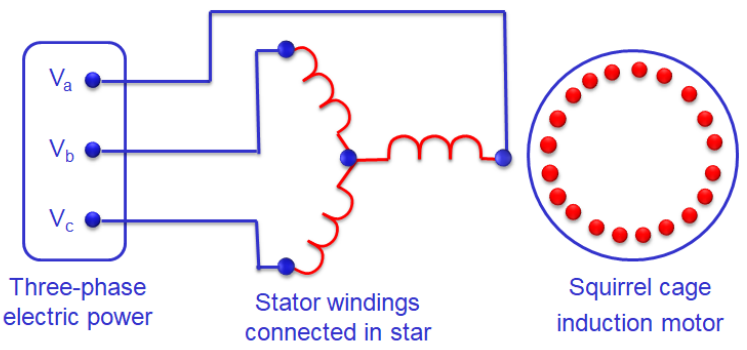
Figure 10. Model of an induction motor.